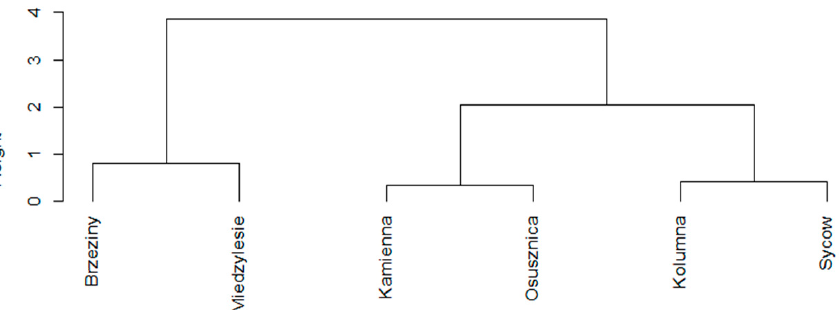
Figure 8. Dendrogram of cluster analysis using Ward’s method for the values of relative growth rates ( RGR d , RGR h ) of silver fir seedlings originating from one of six provenances. The value of agglomeration coefficient = 0.9.